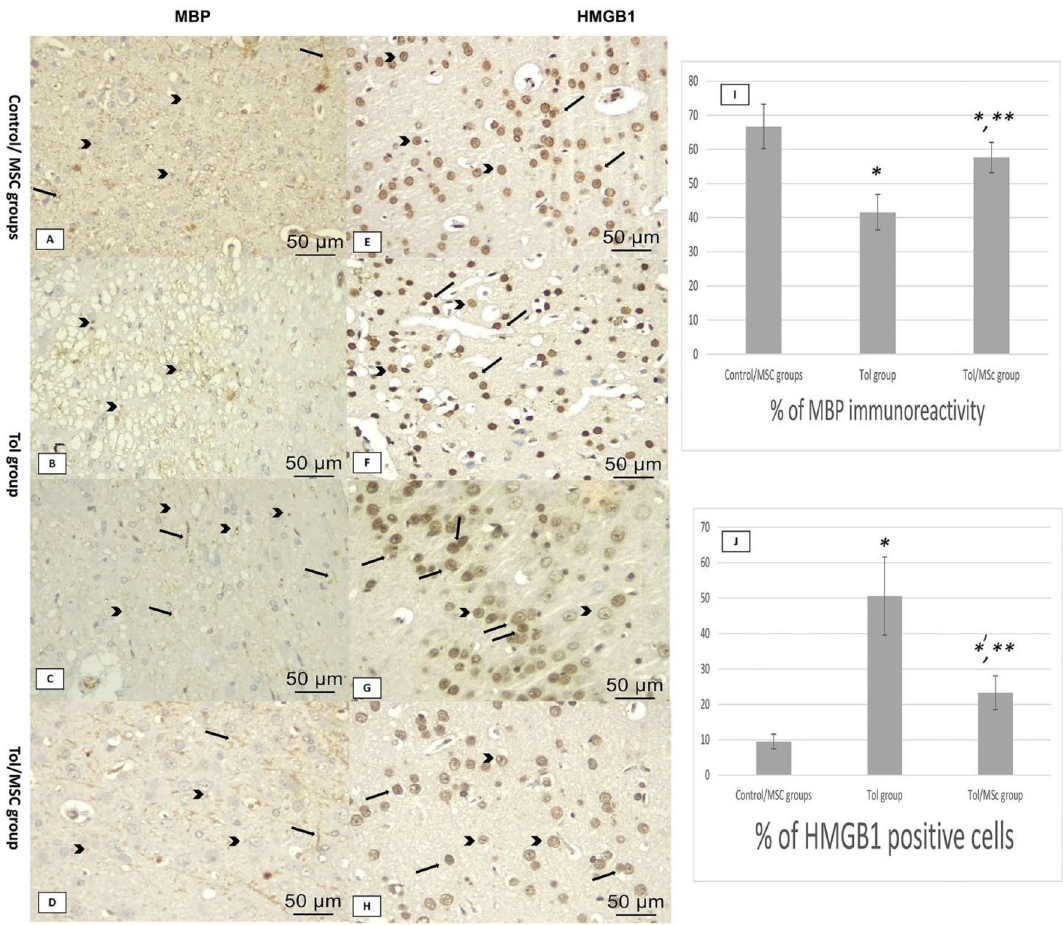
Figure 4. Immunohistochemical staining for anti-MBP, anti- HMGB1; 400 × magnification. Anti-MBP ( A control group; B , C toluene-treated group; D toluene and breast milk MSc-treated group) stained myelin fibers appear as rounded droplets if transverse cuts (arrows heads) and fine lines if longitudinal cuts (arrows) showing b: decreased density of myelin. ( I ) charts showing quantitative analysis of the percentage of MBP immunoreactivity. Anti- HMGB1 ( E control group; F , G toluene-treated group; H : toluene and breast milk MSc-treated group) Anti-HMGB1 stained normal cell bodies appear intact with a dark brown nucleus and faint cytoplasm (arrows heads). HMGB1-positive cells appeared disarranged with dark brown stained cytoplasm (arrows). ( J ) charts showing quantitative analysis of the percentage of HMGB1 positive cells in each group. Data were represented as mean ± SD, *Significant vs control group, **significant vs toluene